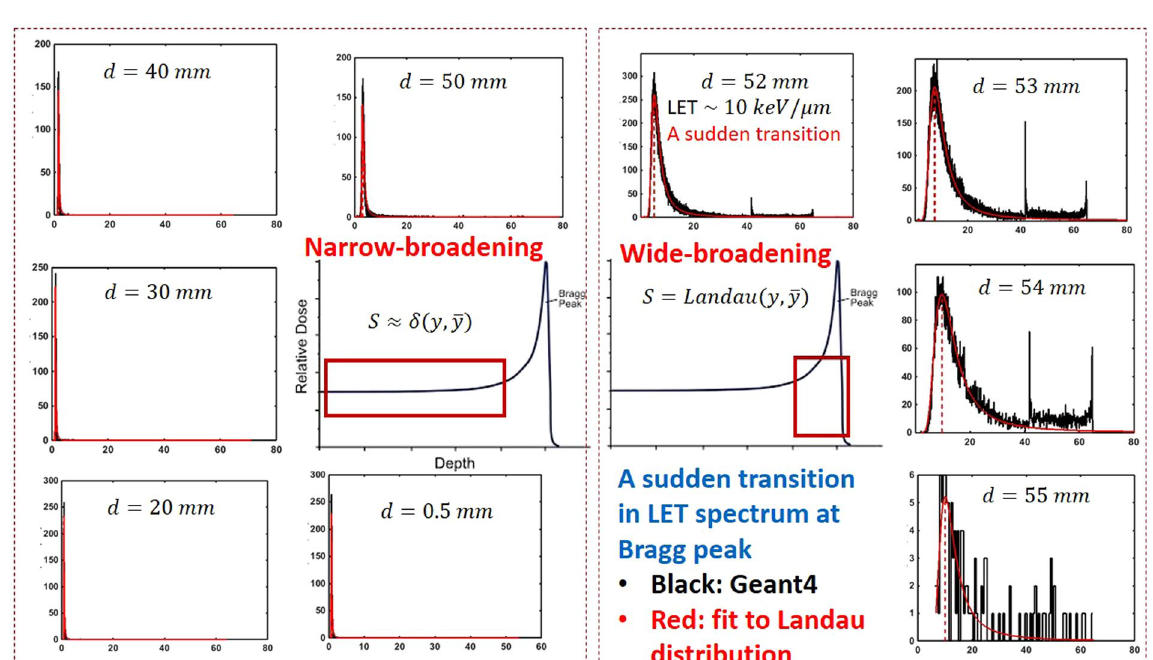
Figure 2. Series of the lineal energy spectrum and the fitting to Landau distribution is shown for a beam of proton with energy 80 MeV as an increasing function of depth in clockwise order. The x-axis and y-axis represent the lineal energy in keV / μ m and the histogram of lineal energy in ( keV / μ m ) − 1 . An abrupt transition in shape of the lineal energy distribution function from sharply symmetric to wide and asymmetric form is seen at 5.2 cm depth where LET ≈ 10 keV / μ m (see Fig. 1c) and LET exceeds 10 keV / μ m